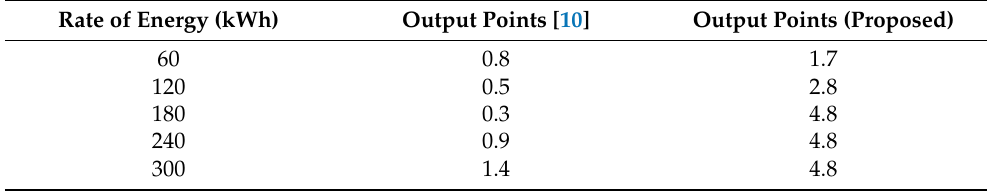
Table 2. Output points with energy deviance.